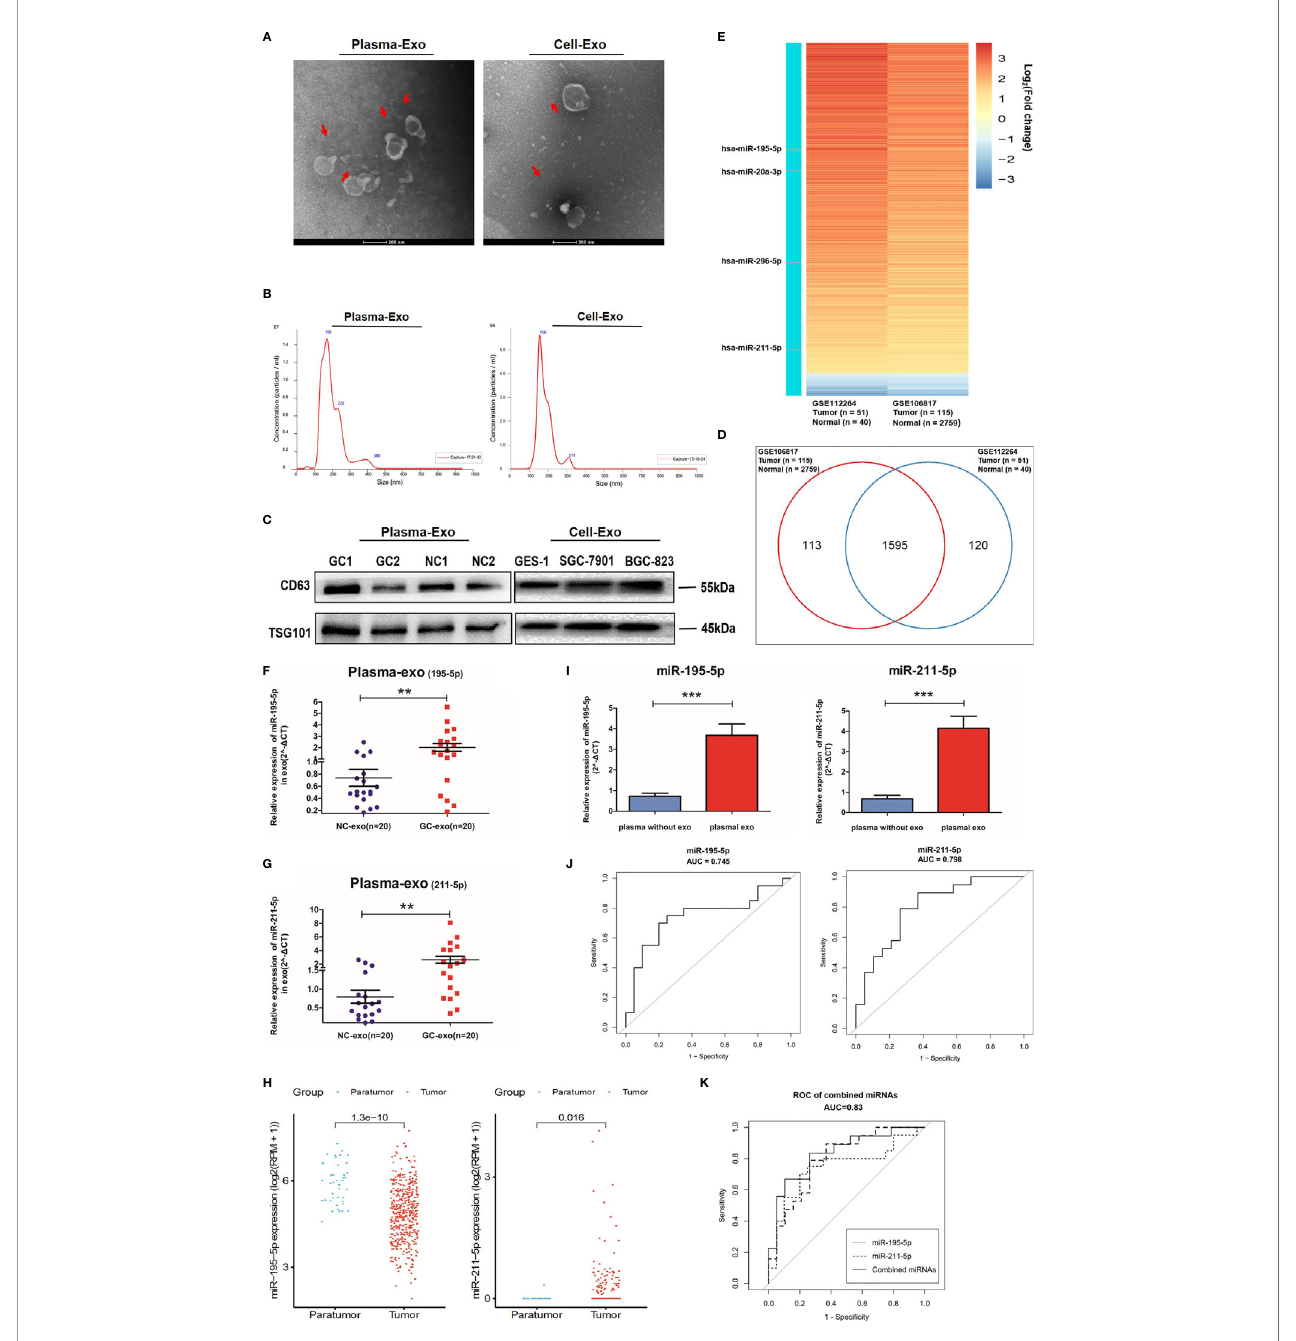
FIGURE 2 | Screening phase of pro fi ling exosomal miRNA. (A) Representative electron microscopy micrographs of plasma and cell conditioning medium secreted exosomes. Scale bar, 200nm. (B) Nano Sight particle-tracking analysis to verify number and size distribution of exosomes. (C) Exosomal markers, TSG101and CD63, of cells and plasma derived exosomes were analyzed with western blotting analysis. (D) Wayne diagram shows that the 1595 miRNAs were found at high levels in both the GSE112264 and GSE106817 datasets. (E) Heat map showing the miRNA expression pro fi le in GSE112264 and GSE106817 data set based on the criteria of fold change >2.0 and adjusted p-value <0.01. (F, G) Healthy patients and GC patients (n=20) provided serum plasma which was then analyzed with qRT-PCR for plasma exosomal miR-195-5p and miR-211-5p levels. (H) miR-195-5p and miR-211-5p expressions were noted to be statistically signi fi cant in GC tissues of the TCGA database. (I) Comparison between miR-195-5p and miR-211-5p between non-exosome plasma and plasma with exosomes. Each value represents the mean ± SD; ***p-value < 0.001. (J) The sensitivity and speci fi city of plasma exo-miR-195-5p or miR-211-5p for GC prediction was assessed using the receiver-operating characteristic (ROC) curve analysis. (K) ROC analysis of miR-195-5p combined with miR-211-5p. Each is presented in terms of mean ± SD; **p-value